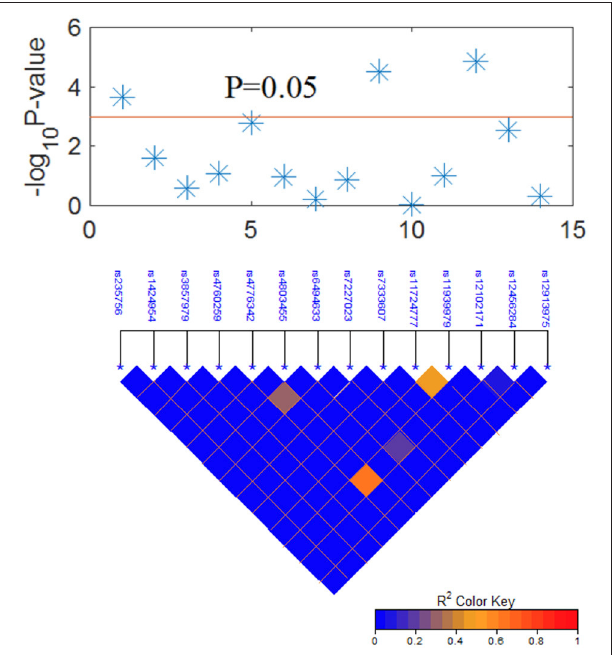
FIGURE 2 | Graphical representation of the P -value obtained from individual SNP analysis and linkage disequilibrium (LD) structure.